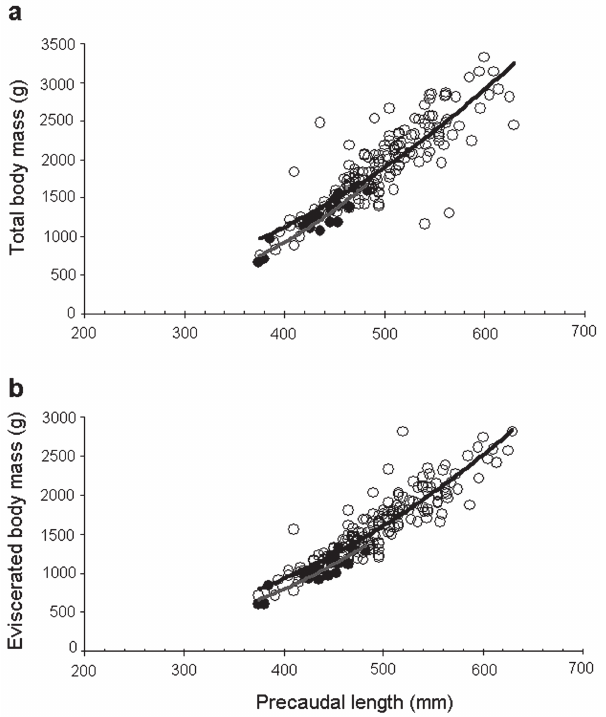
Fig. 3 . Relationships for Callorhinchus callorynchus males (black circles; grey line; n=19) and females (white circles; black line; n=167) between precaudal length and a. total body mass and b. eviscerated body